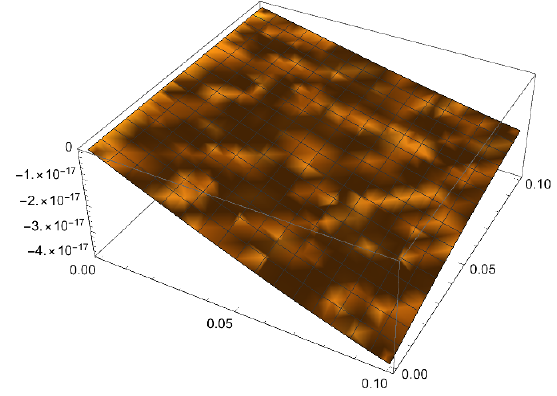
Figure 1 . Behaviour near (cid:26) = 0 ; v = 0, in the range 0 (cid:20) (cid:26) (cid:20) 0 : 1 ; 0 (cid:20) v (cid:20) 0 :